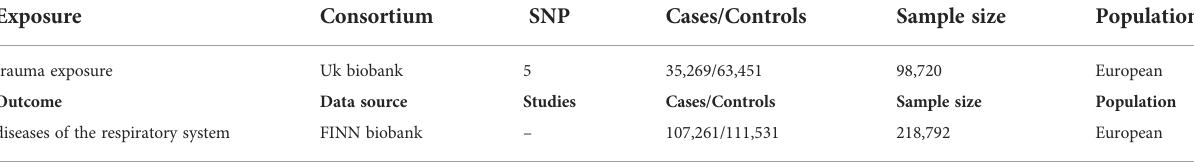
TABLE 1 Characteristics of trauma exposure and diseases of the respiratory system